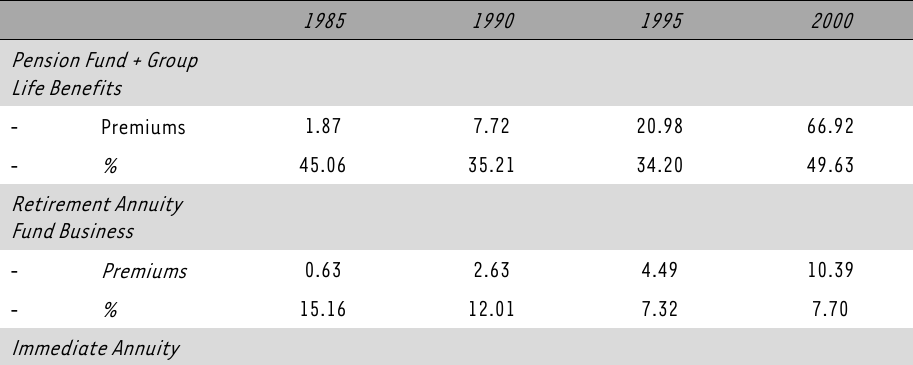
TABLE 5: Product segmentation in the long-term insurance market, 1985-2000 (R’bn)